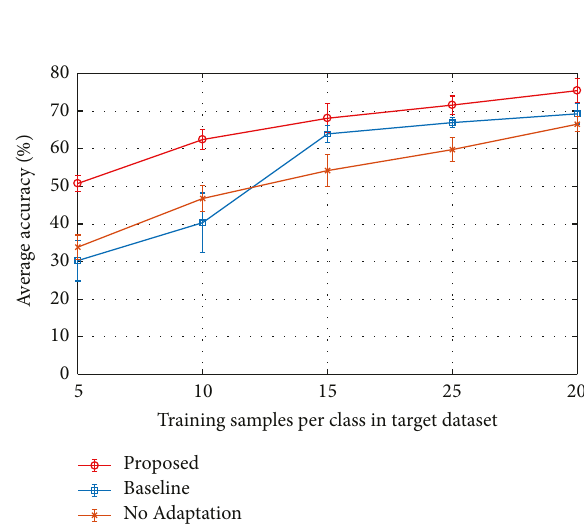
Figure 7: Performance comparison of our proposed method with the baseline method and the No Adaptation (NA) method on the InfAR